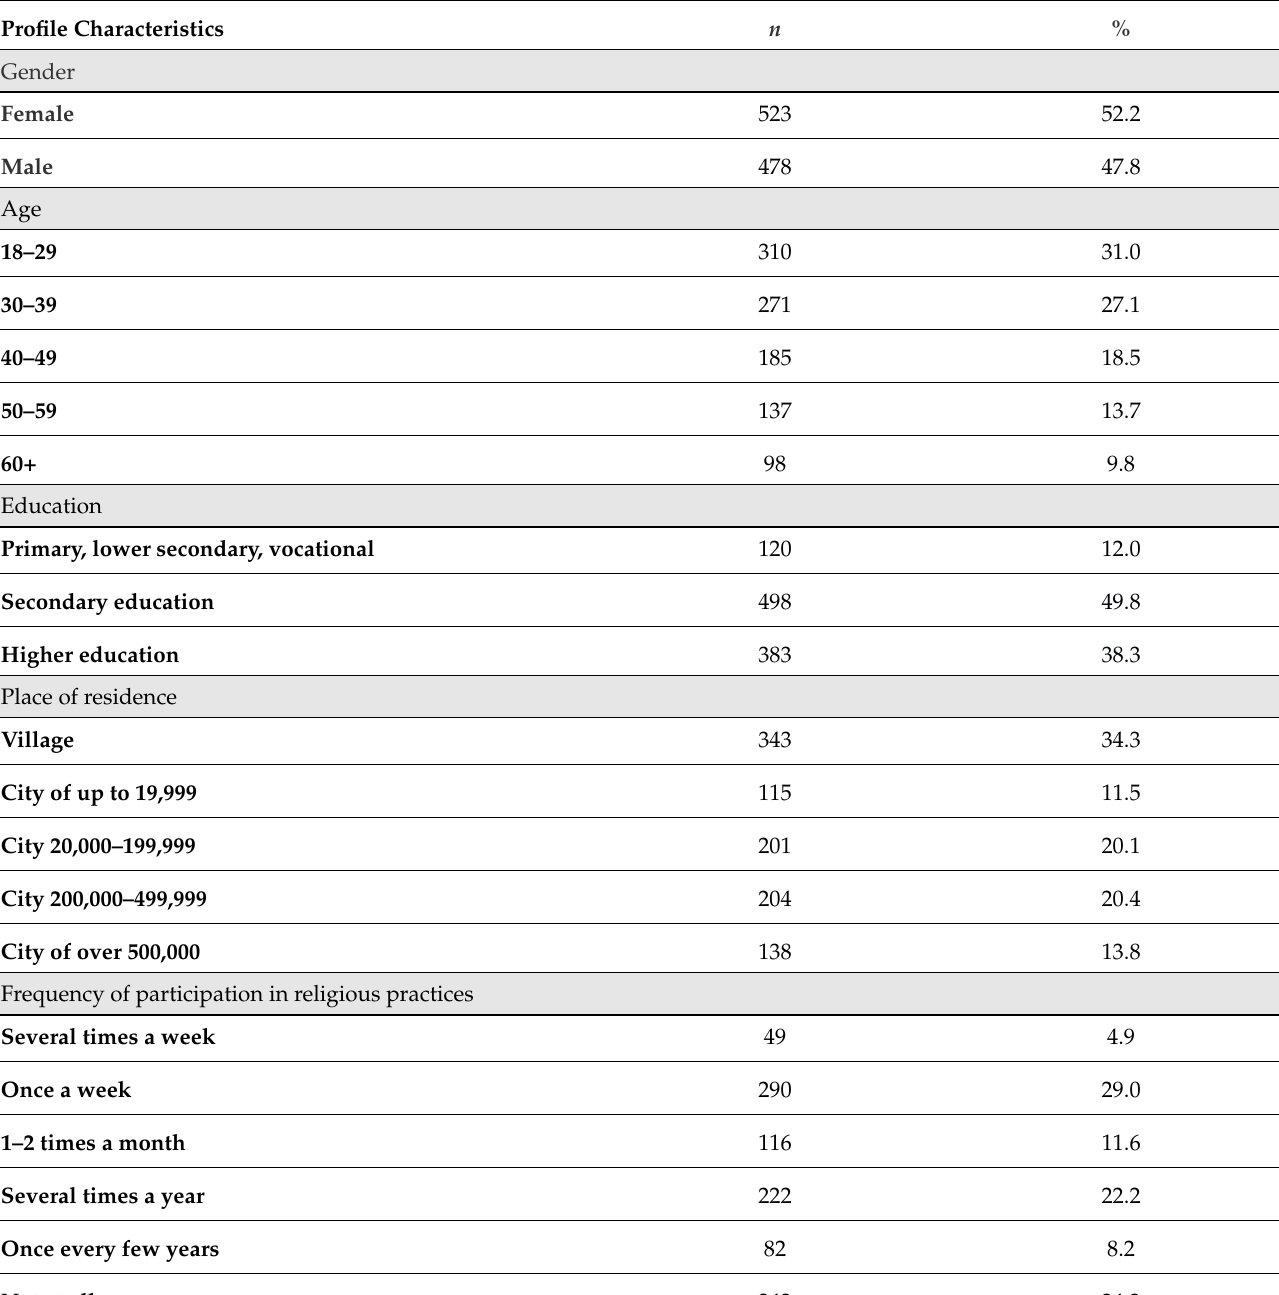
Table A1. Distribution of socio-demographic characteristics in the studied